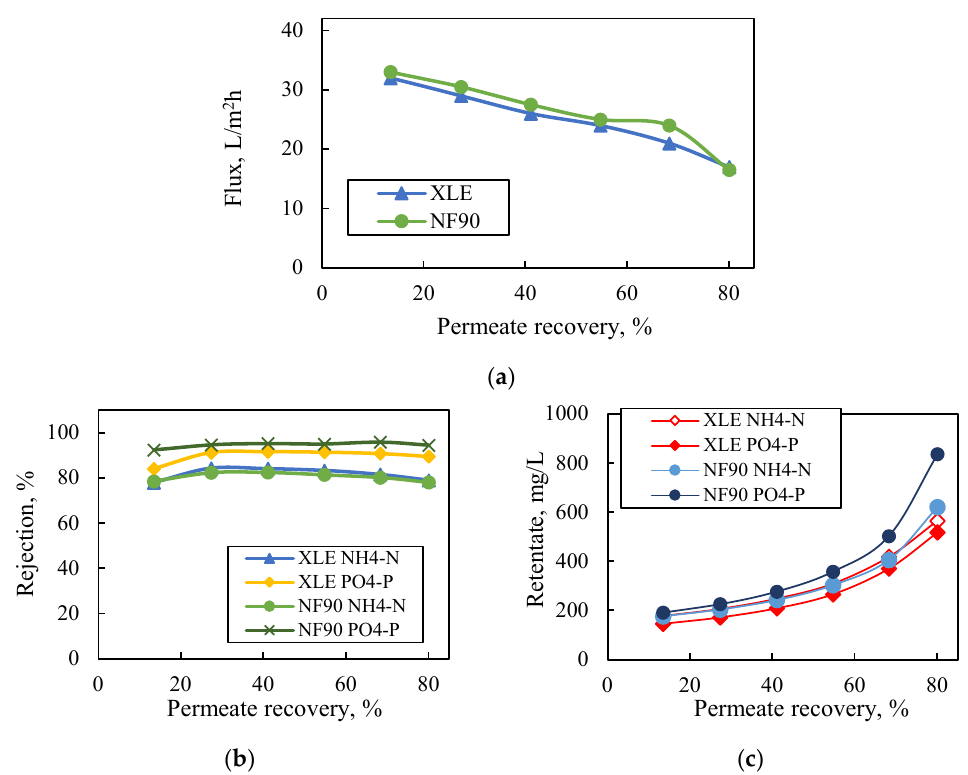
Figure 4. Effect of permeate recovery on ( a ) flux, ( b ) nutrient rejection, ( c ) nutrient concentration in retentate. Feed: synthetic solutions of NH4-N and PO4-P (150 mg/L each); NF90 and XLE membranes. Dead-end filtration, constant pressure 5 bar.